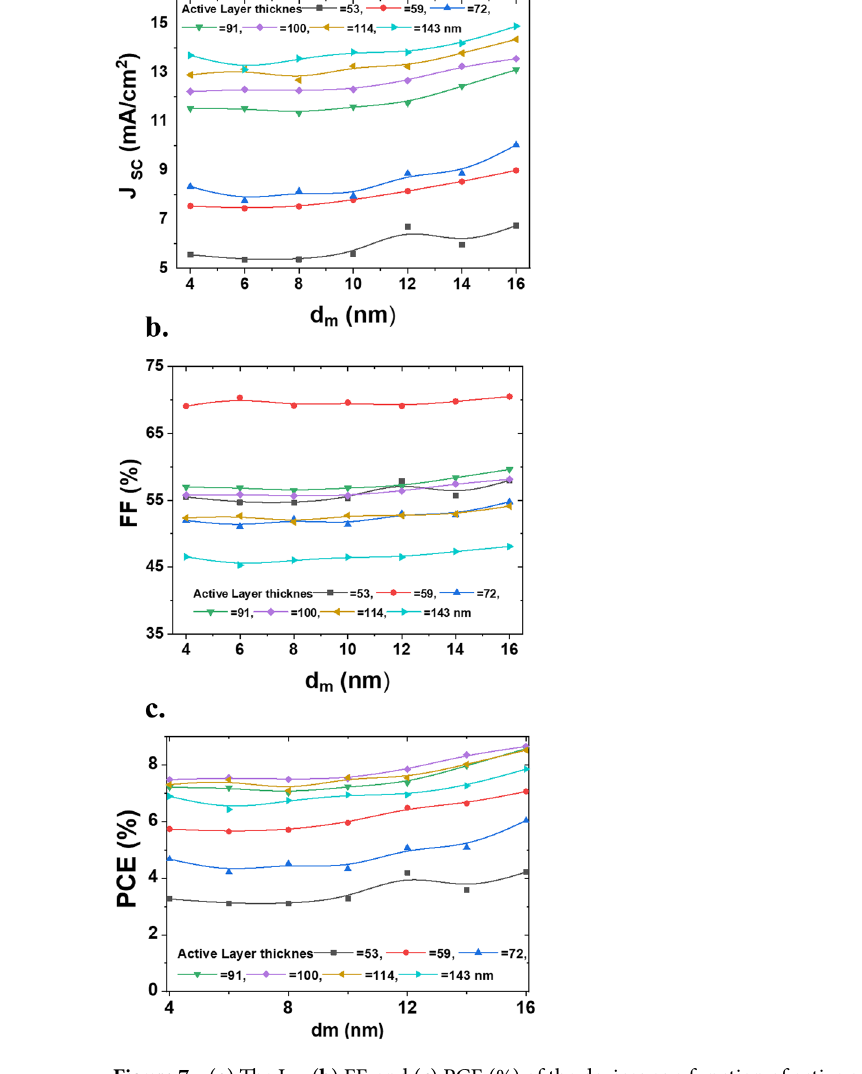
Figure 7. ( a ) The J SC , ( b ) FF, and ( c ) PCE (%) of the devices as a function of active and ‘d m ’ layer thicknesses.